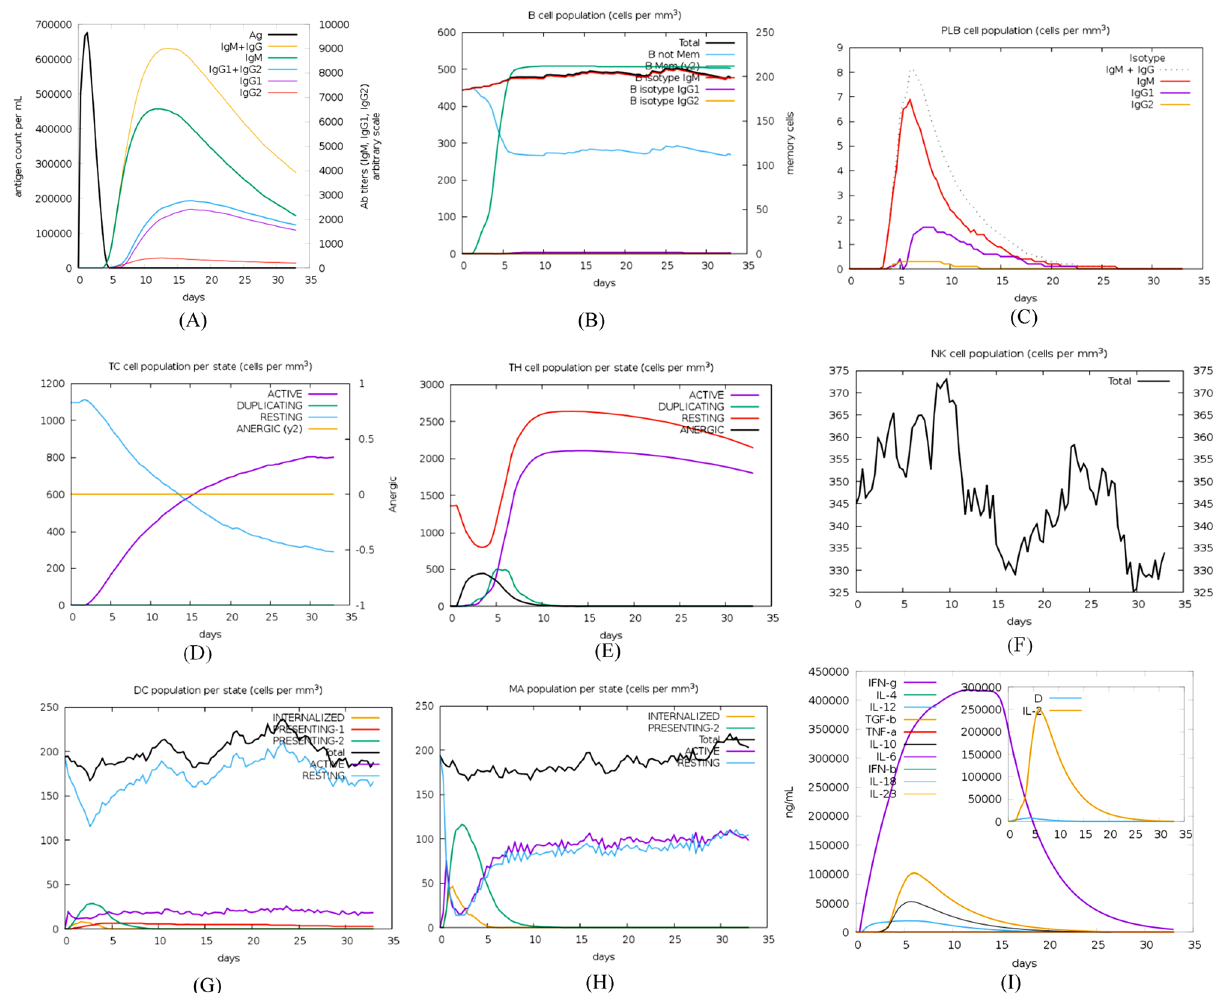
Figure 10. C-ImmSim presentation of an in silico immune simulation with the proposed vaccine. ( A ) immunoglobulin and immunocomplex response to the antigen. ( B ) B lymphocytes: total count, memory cells, and sub-divided in isotypes (IgM, IgG1 and IgG2). ( C ) Plasma B lymphocytes count sub-divided per isotype (IgM, IgG1 and IgG2). ( D ) CD8 T-cytotoxic lymphocytes count per entity-state. ( E ) CD4 T-helper lymphocytes count sub-divided per entity-state (i.e., active, resting, anergic and duplicating). ( F ) Natural Killer cells (total count). ( G ) Dendritic cells. DC can present antigenic peptides on both MHC class-I and class-II molecules. The curves show the total number broken down to active, resting, internalized and presenting the ag. ( H ) Macrophages. Total count, internalized, presenting on MHC class-II, active and resting macrophages. ( I ) The plot displays cytokine levels after injections. The insert plot illustrates the IL-2 level with the Simpson index, D represented by the dotted line. D is a diversity metric. Increase in D over time implies formation of various epitope-specific dominant clones of T-cells. The lower the D value, the lower the